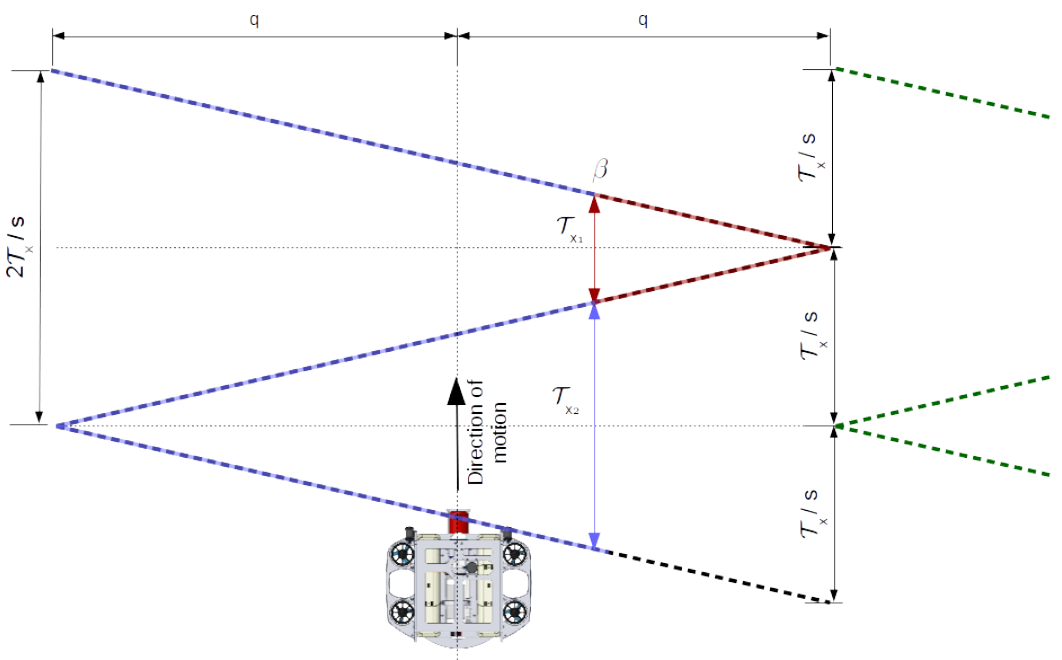
Figure 8. Sector sampling of a flat region. Dashed black lines represent the readings of a sensor, while green dashed lines represent the reading of an adjacent sensor. The distance between readings at the same head position, β , but subsequent time-steps, presents different values—depending on the path taken by the sensor. The Long path (blue dashed) results in greater distance between samples than the shorter path (red dashed). Smaller and larger distances alternate each other and also that the sum of both is 2 T x s